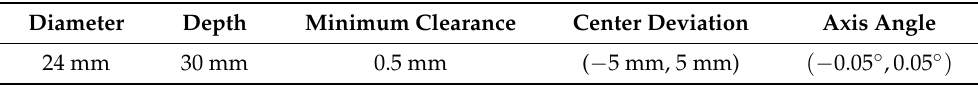
Table 2. Assembly workpiece parameters.